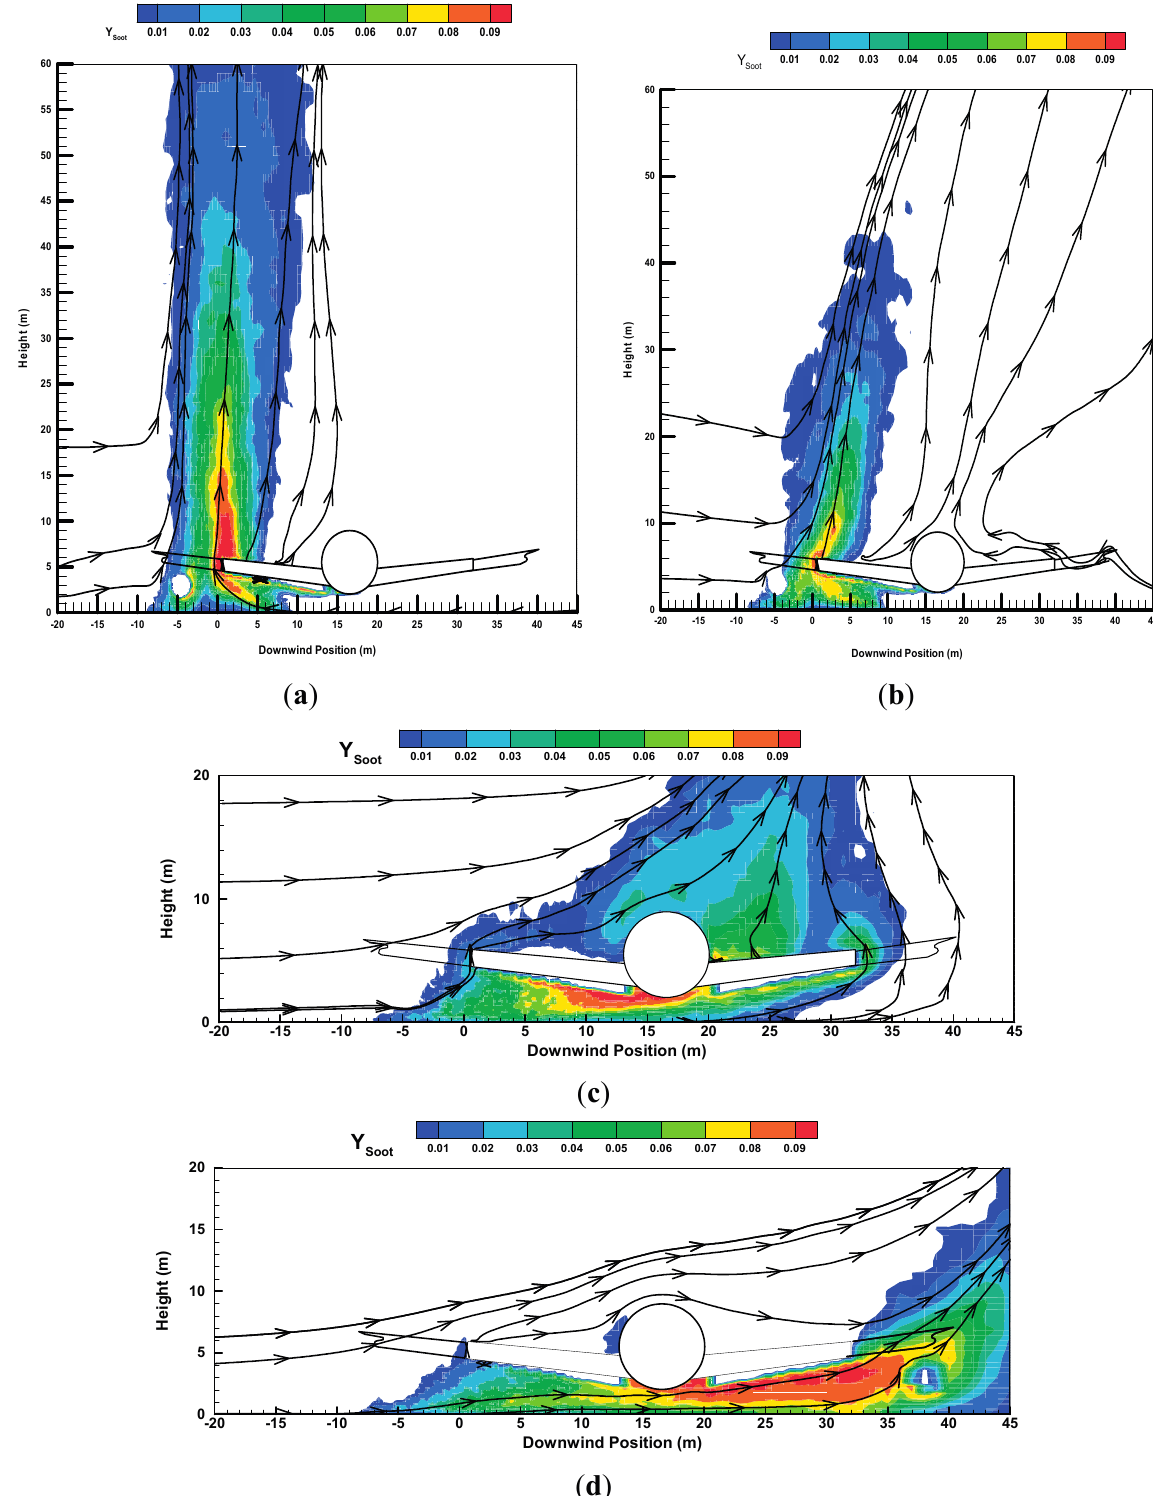
Figure 15. Contours of the time-averaged soot mass fraction for fires containing an aircraft of the composite type. ( a ) Quiescent condition; ( b ) low wind speed of 2 m/s; ( c ) medium wind speed of 5 m/s; ( d ) high wind speed of 10